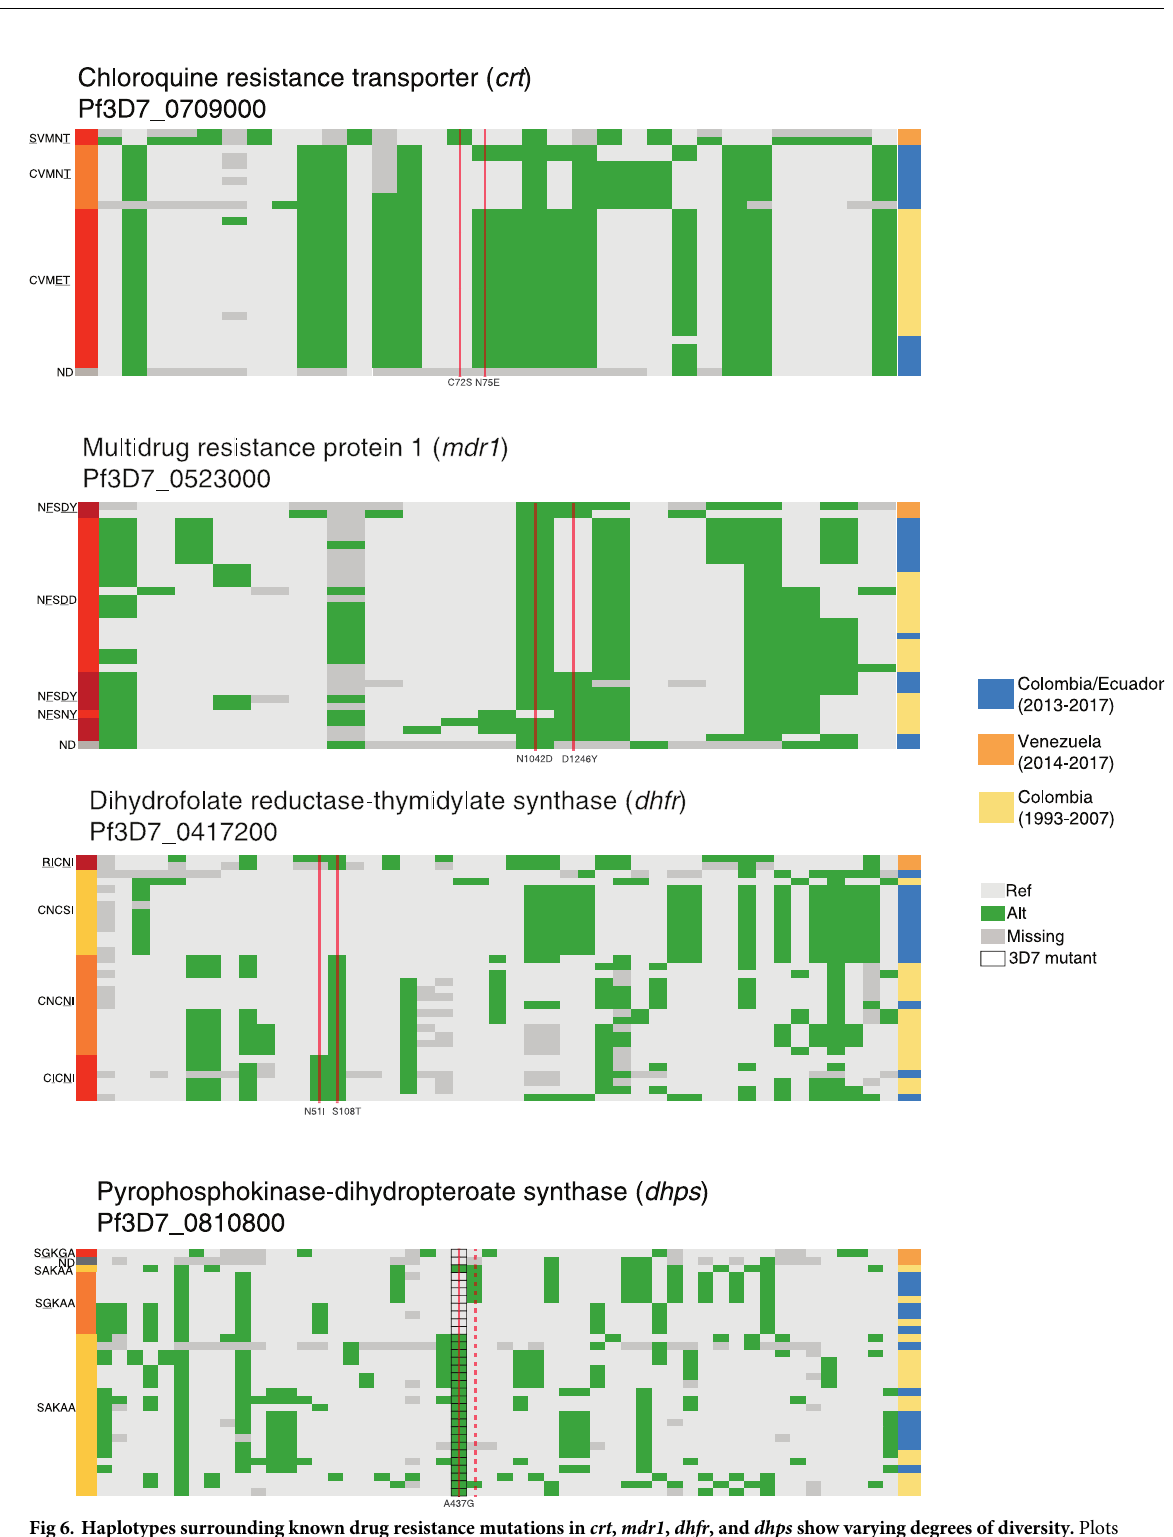
Fig 6. Haplotypes surrounding known drug resistance mutations in crt , mdr1 , dhfr , and dhps show varying degrees of diversity. Plots display segregating SNPs within the 30-kb flanking regions around mutations of interest within four genes involved in antimalarial drug resistance. One high-coverage sample from each clonal cluster is displayed (rows). SNP positions were removed if they were within five nucleotides of a called indel or if they displayed a high rate of heterozygous calls within monoclonal samples (Materials and Methods). Calls are colored based on matching (light grey) or mismatching (green) the 3D7 reference. Calls are marked as missing (dark grey) if they